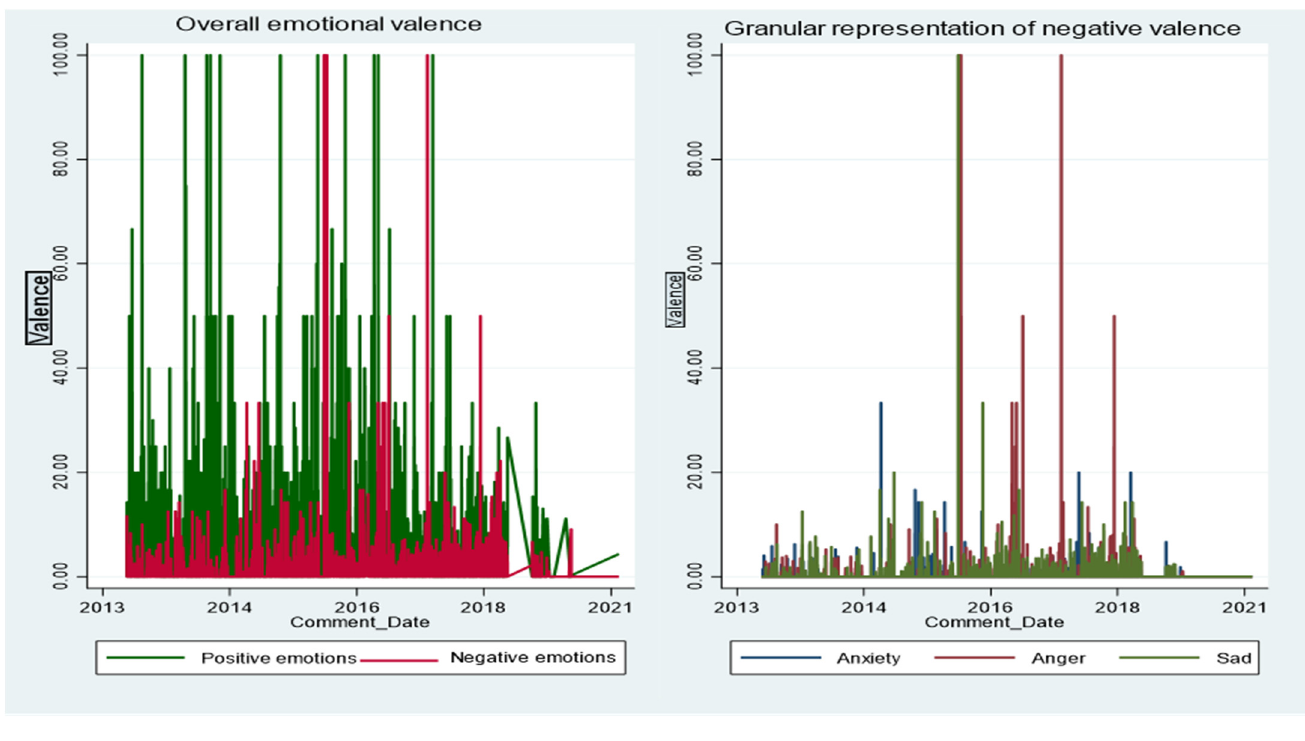
Figure A1. ( a ) Temporal representation of emotional valence of backers: Campaign Glowing Plants: Natural Lighting with no Electricity. ( b ) Temporal representation of emotional valence of backers: Campaign Coolest Cooler: 21st Century Cooler that’s Actually Cooler. ( c ) Temporal representation of emotional valence of backers: Campaign HOT Watch: Complete Smart Watch w/Revolutionary Private Calls. ( d ) Temporal representation of emotional valence of backers: Campaign vrAse: The Smartphone Virtual Reality Case. ( e ) Temporal representation of emotional valence of backers: Campaign Vertus—Spread the Music Without Wires. ( f ) Temporal representation of emotional valence of backers: Campaign Neptune Pine: Smartwatch. Reinvented. ( g ) Temporal representation of emotional valence of backers: Campaign Radiate Athletics: The Future of Sports Apparel.